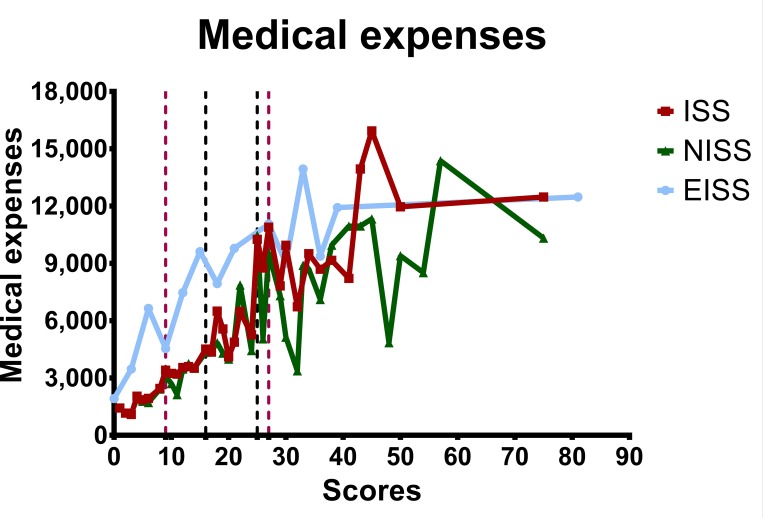
The total medical expenses-to-severity score relationships of all patients classified according to the ISS, NISS, and EISS.